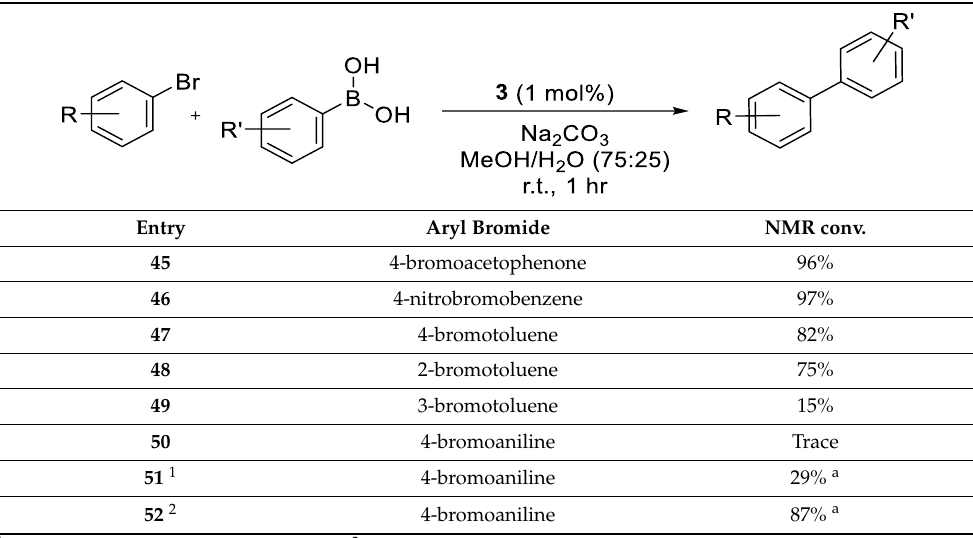
Table 6. Substrate scope investigating the effect of changing the aryl bromide coupling to phenyl- boronic acid.